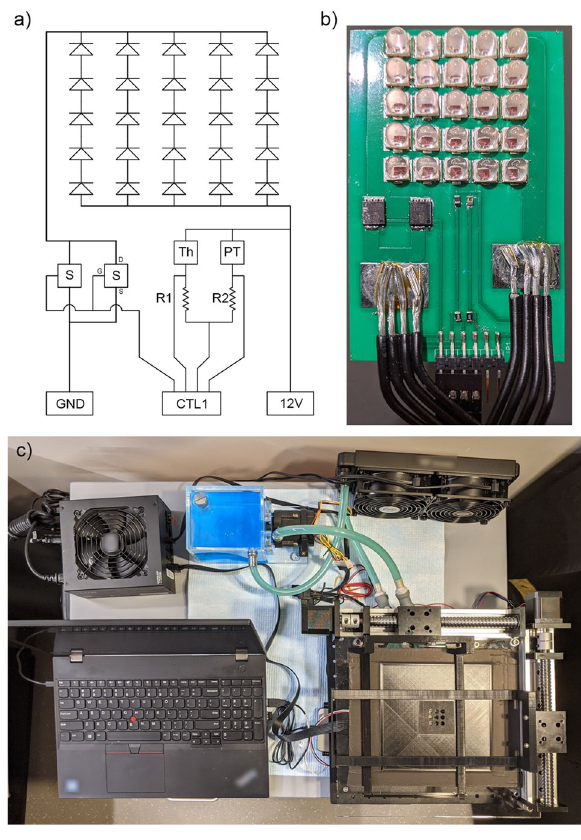
Figure 1. ( a ) A schematic top view of the LED array PCB. The positions of the components match the actual position on board. S, MOSFET switch; Th, thermistor; PT, phototransistor; CTL1, connector to the DAQ;